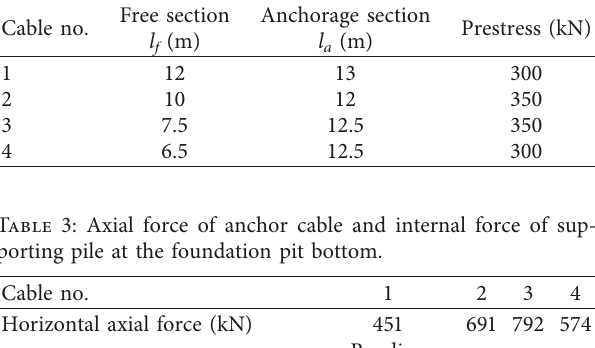
Table 2: Parameters of each anchor cable. Cable no.